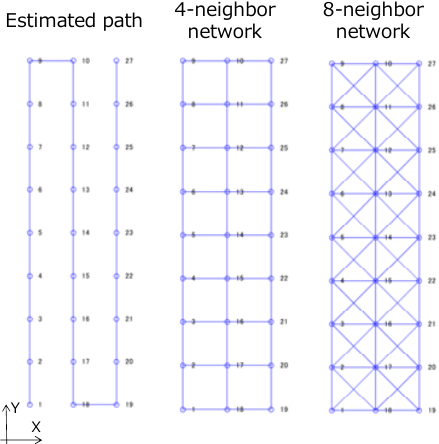
Figure 7. Camera translation estimation result, Corridor 2 (Left image: actual camera path, right image: our estimated result) Figure 8 shows our estimated camera translation in the room. The X and Y axes indicate horizontal camera position.